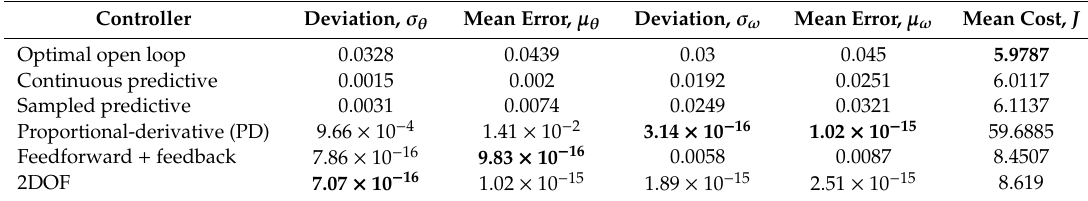
Table 1. Statistical analysis via Monte Carlo simulations 1